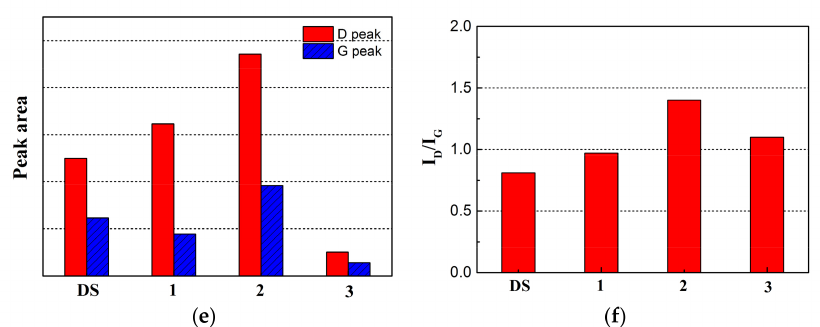
Figure 15. Raman analysis. ( a – d ) Gaussian fitting applied for D and G peaks fitting of DS and 1#–3#. ( e ) The fitting results of the D and G peaks intensity, and ( f ) the intensity ratio of the D peak to the G peak ( I D / I G